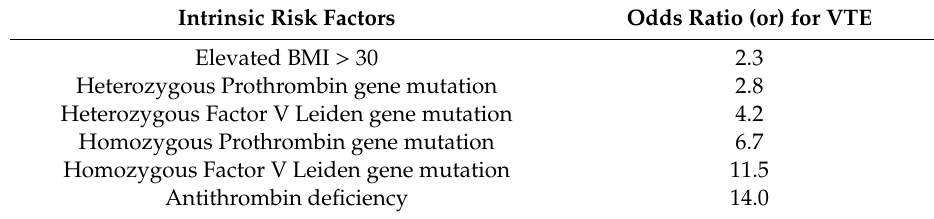
Table 1. Association of Patient-Specific Risk Factors With Risk of First Episode of VTE